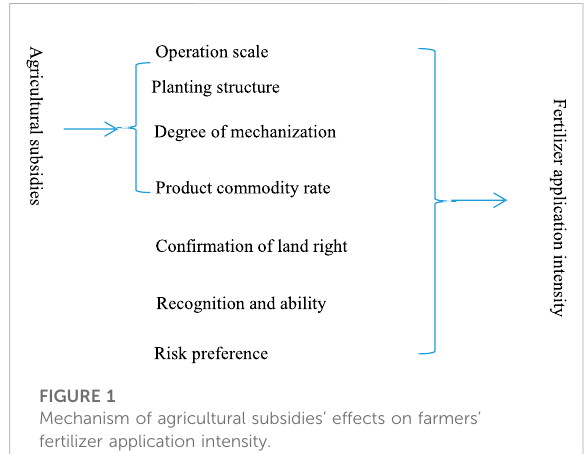
FIGURE 1 Mechanism of agricultural subsidies ’ effects on farmers ’ fertilizer application